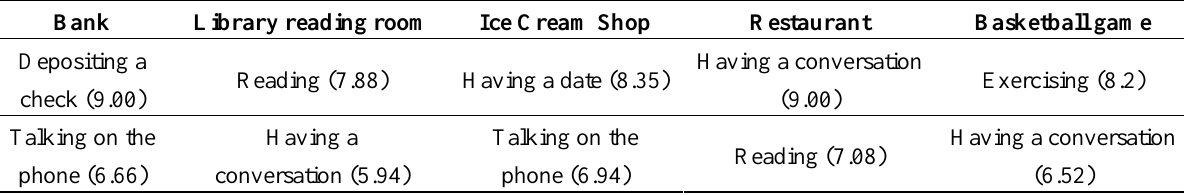
Table 5. The activities to be assessed in relation to each animation in Experiment